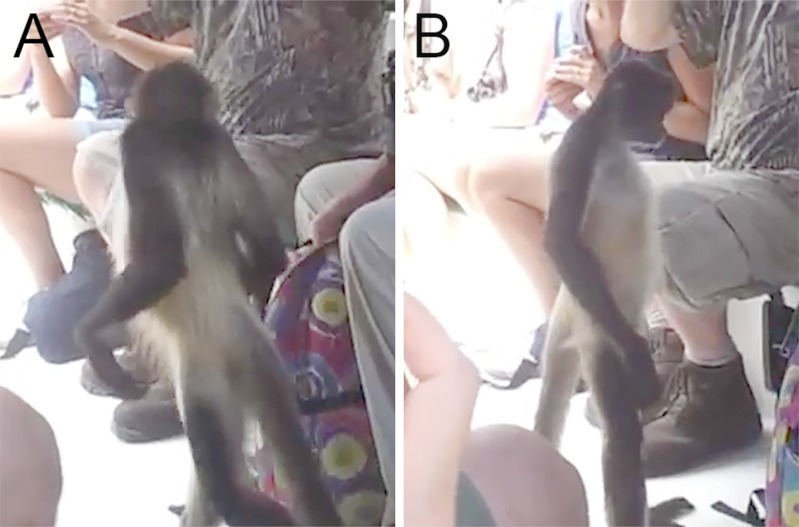
Bipedal posture in a spider monkey.Screen captures of video demonstrating bipedal posture and locomotion. (A) Posterior lateral view demonstrating that the spider monkey attains erect hip and back during bipedal standing without relying on support. (B) Lateral view illustrating that hip extension approximates 160°. Images from BigLivigVideos, (2012); full video can be seen as Video S3.